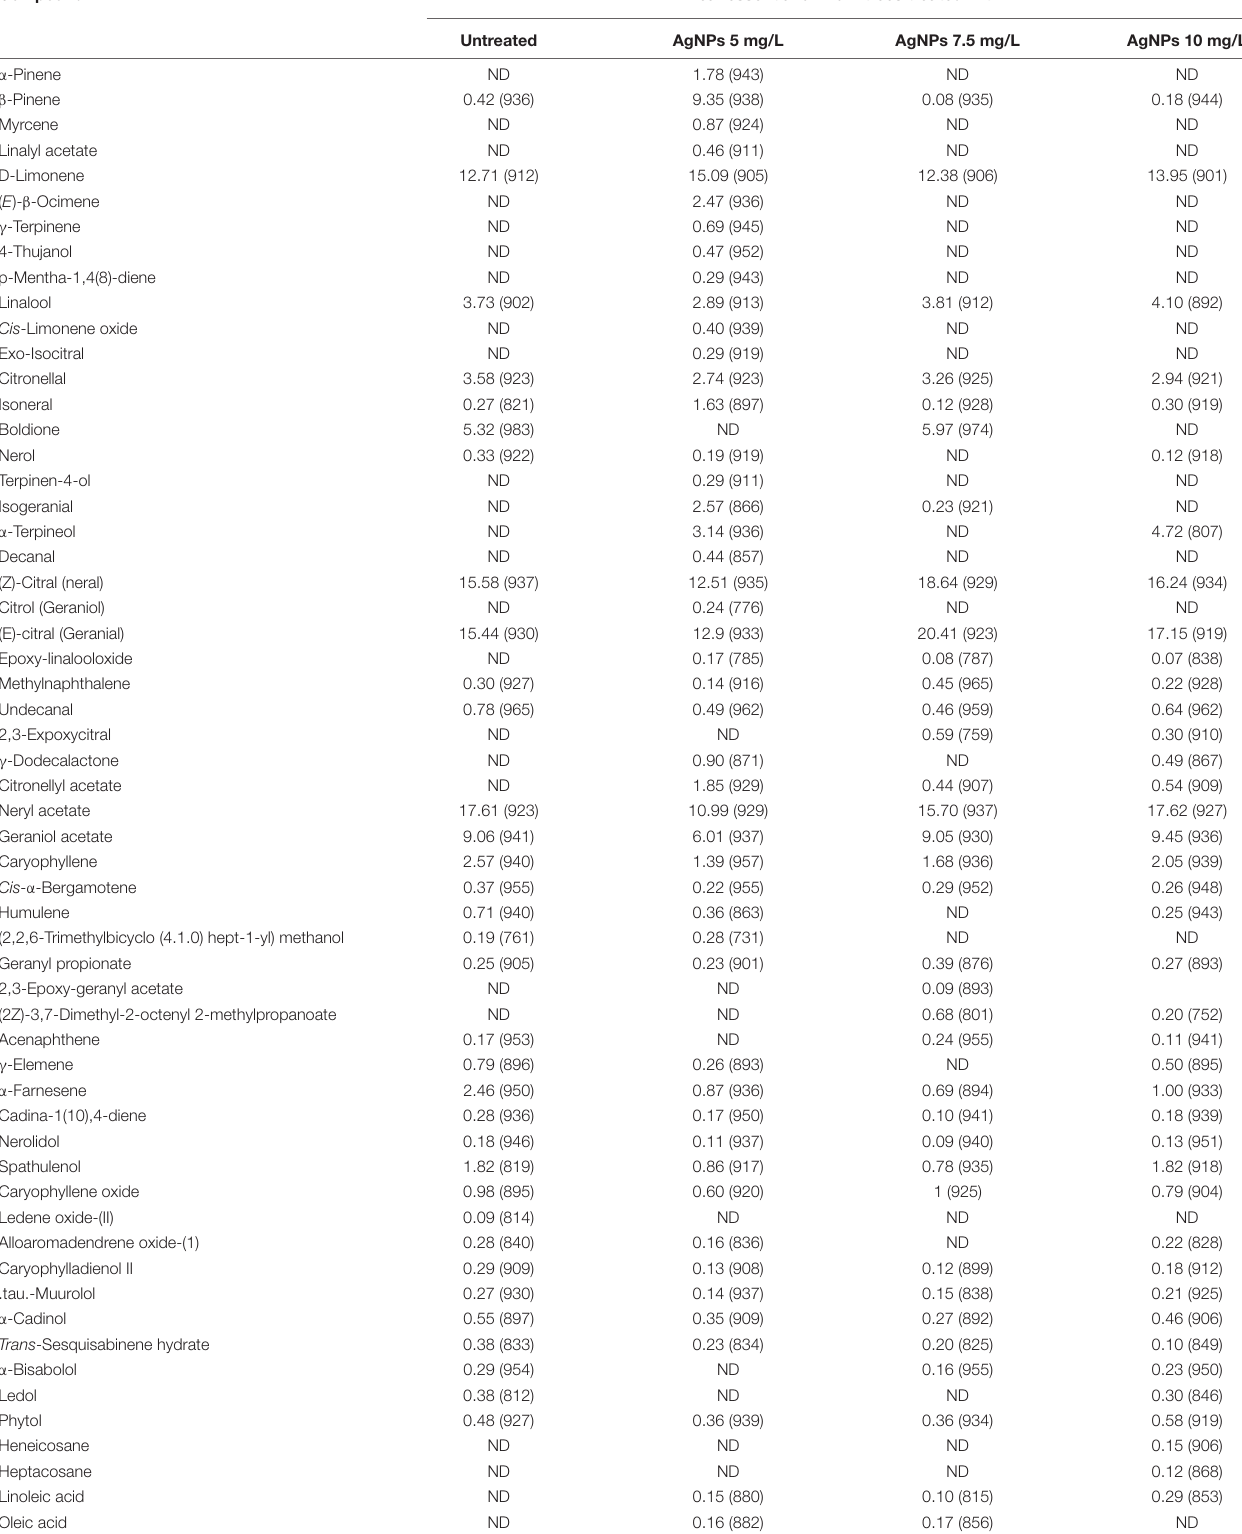
TABLE 9 | Chemical compositions of essential oils from leaves of Citrus limon .